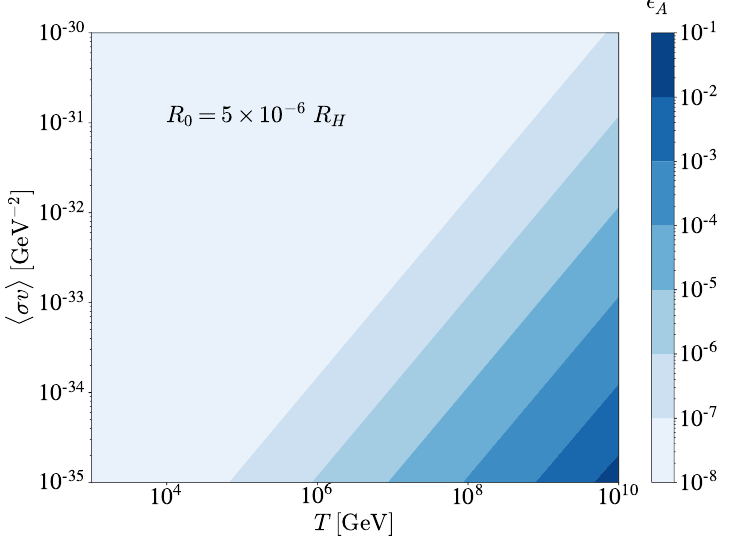
Figure 5 . The minimum asymmetry needed to be generated by the annihilation processes in the h σv i − T plane, in the scenario with R 0 = 5 × 10 − 6 R H , where annihilation dominates. final asymmetry in baryons. For example, if χ depletion produces an asymmetry in lepton number that is subsequently converted into a baryon asymmetry via electroweak sphalerons (“leptogenesis”), C ’ 12 / 37